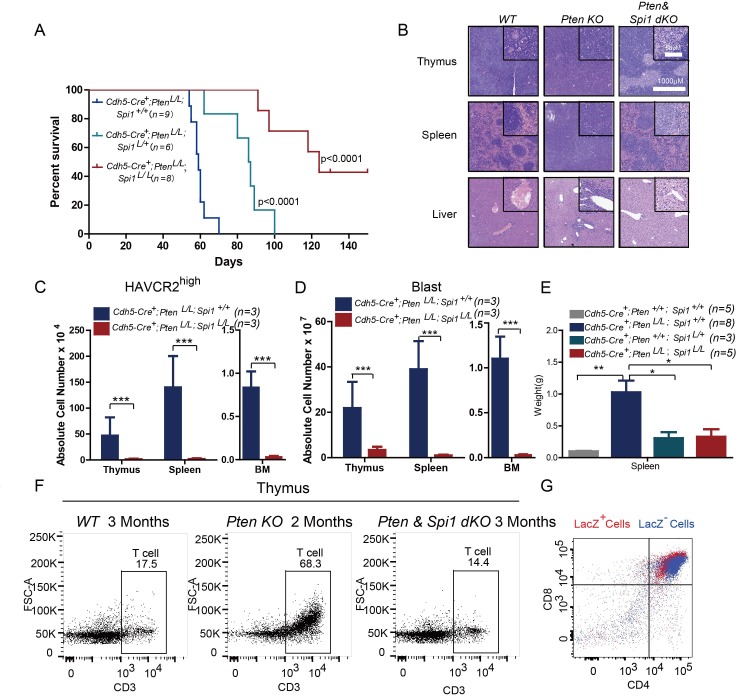
SPI1 is essential for LSC formation and T-ALL development.(A) Survival curves for Cdh5-Cre+;PtenL/L T-ALL model mice (blue line) with heterozygous (Cdh5-Cre+;PtenL/L;Spi1L/+; green line) or homozygous (Cdh5-Cre+;PtenL/L;Spi1L/L; red line) Spi1 conditional deletion; (B) HE-stained images of thymus, spleen and liver tissue from 2-month-old mice with the indicated genotypes;(C–D) Comparison of the absolute number of HAVCR2high and blast cells in each organ in 2-month-old Cdh5-Cre+;PtenL/L (blue bars) and Cdh5-Cre+;PtenL/L;Spi11L/L (red bars) mice;(E) Comparison of spleen weights in the mice in B-C; (F) Representative FACS plots show CD3-positive T cells in the thymus of WT, Pten-null T-ALL and Pten/Spi1 double knockout mice. WT and Pten/Spi1 double knockout mice were 3 months old, and Pten-null T-ALL mice were 2 months old. n = 3; (G) FACS-Gal analysis of T cell development in the thymus of Pten/Spi1 double knockout mice. LacZ+ cells (red dots) and LacZ−cells (blue dots) from the same sample are overlaid. C-D, the data are presented as the means ± S.Ds; *p≤0.05; **p≤0.01; ***p≤0. 001.The bars in the HE images and inserts represent 1000 μM and 50 μM, respectively.